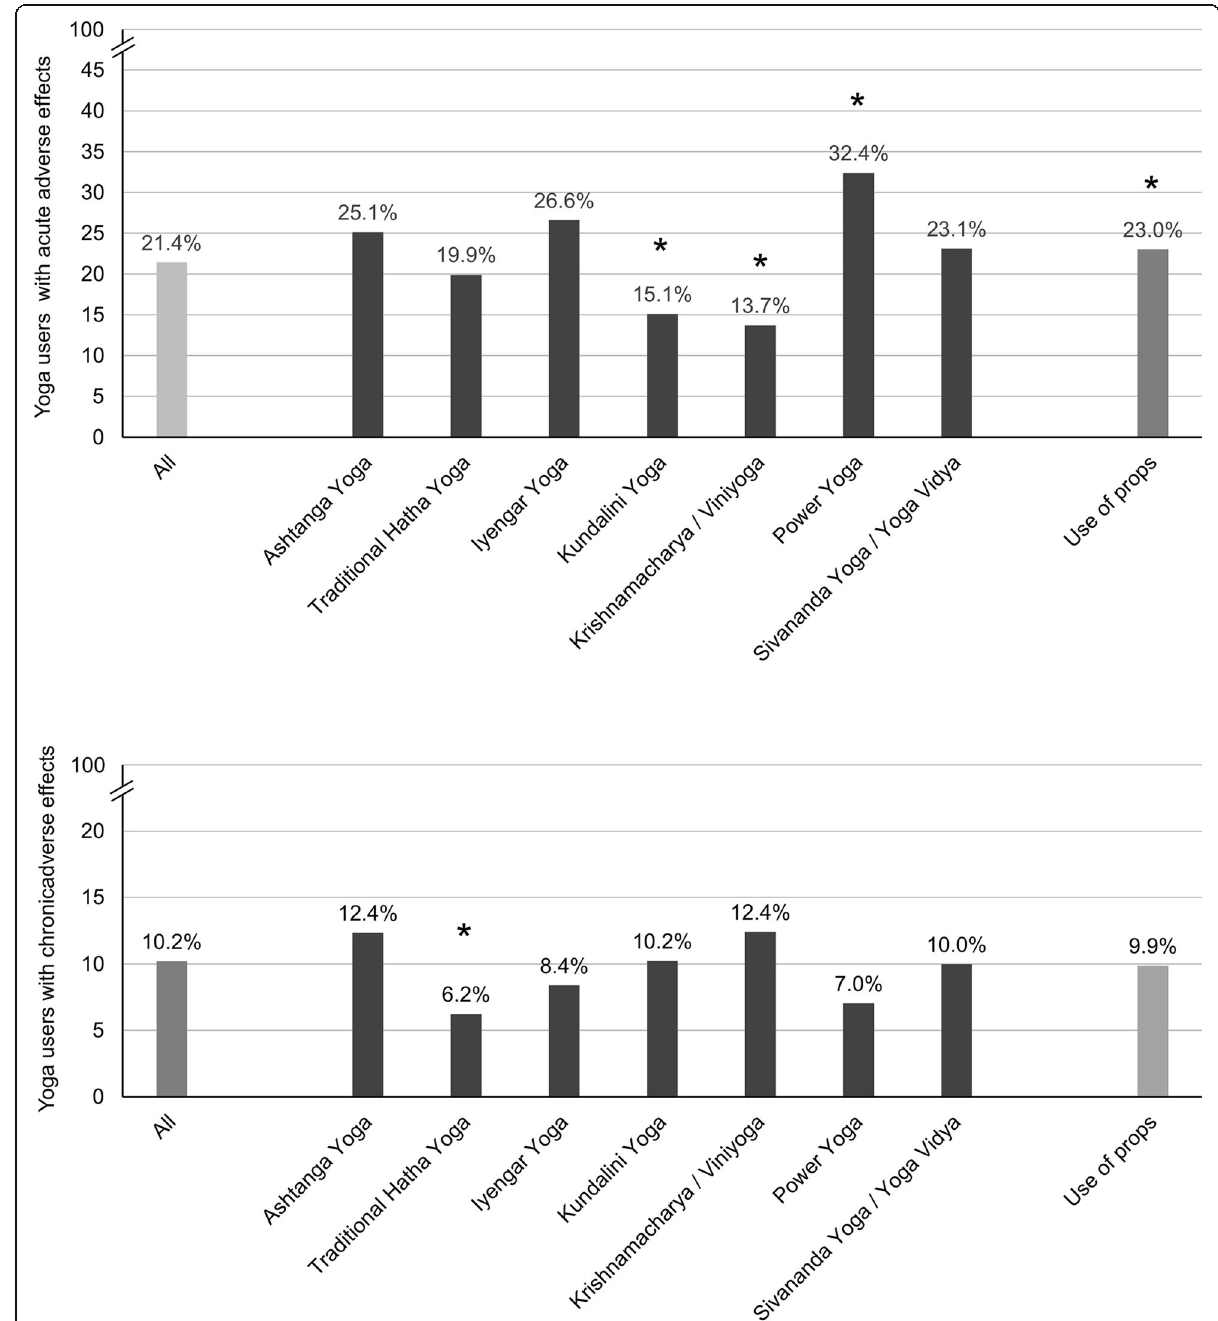
Fig. 2 Rates of acute and chronic adverse effects by yoga style and props use ( n = 1702). Asterisks indicate significantly higher or lower